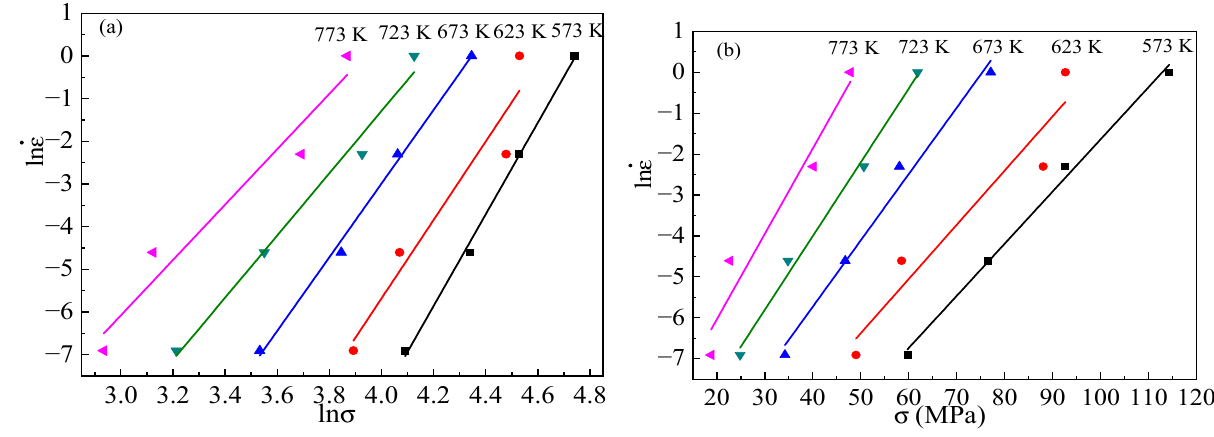
Figure 6. Relationships of ( a ) ln ε − ln σ ; ( b ) ln ε − σ . Equation (14) can be obtained through the logarithm of Equation (11).